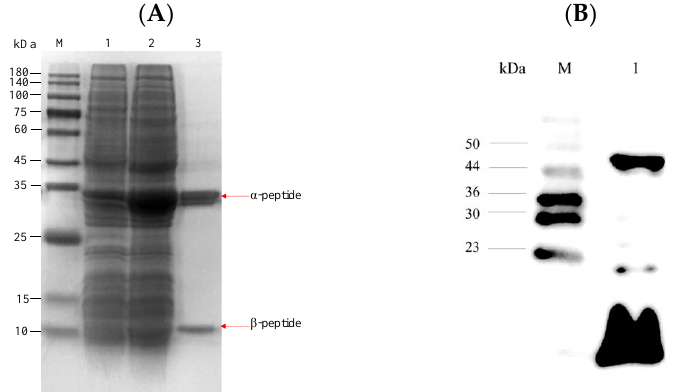
Figure 2. The induced expression of LUCA−DmpA and Western blot analysis. ( A ) SDS-PAGE analysis of LUCA−DmpA only containing N-terminal His-tag. Lane M, the protein marker; lane 1, control; lane 2, the crude enzyme of LUCA−DmpA ; and lane 3, the purified LUCA−DmpA . ( B ) Western blot with an anti-His body performed with the purified LUCA−DmpA only containing a C-terminal His-tag. Lane M, the molecular marker of Western blot and lane 1, the purified LUCA−DmpA with C-terminal His-tag.